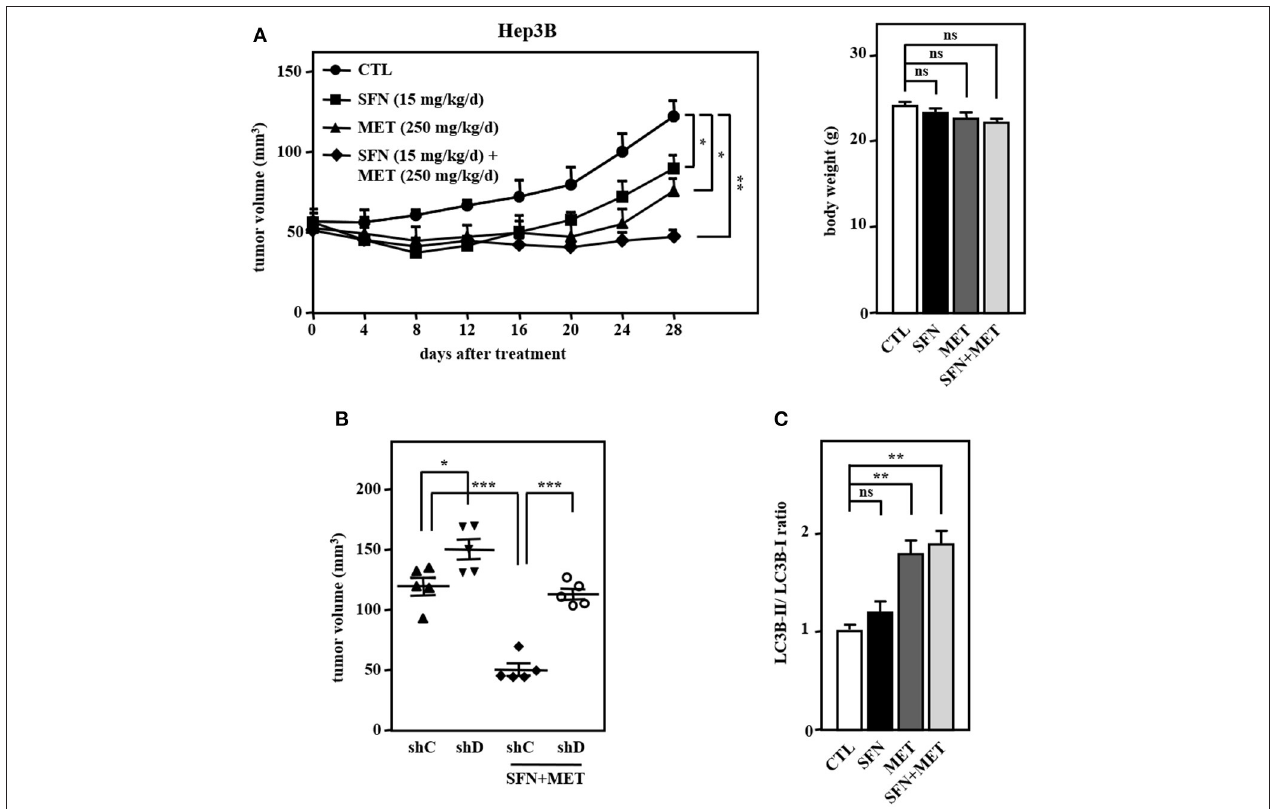
FIGURE 6 | The combination of sorafenib and metformin elicits stronger cytotoxicity in a Hep3B cell xenograft mouse model. Hep3B cells were subcutaneously inoculated into NOD-SCID mice, and the mice then received an intraperitoneal injection of vehicle, sorafenib (15 mg/kg/day), metformin (250 mg/kg/day), or sorafenib (15 mg/kg/day) combined with metformin (250 mg/kg/day). (A) Tumor dimensions were obtained at the indicated time points. Following 4 weeks of drug treatment, the mice were sacrificed, and animal weights were obtained. (B) Hep3B cells were infected with lentiviruses to drive the stable expression of either IPTG-inducible LacZ shRNA (shC) or IPTG-inducible CEBPD shRNA (shD). Infected Hep3B cells were subcutaneously inoculated into the dorsum of 6-week-old NOD-SCID mice ( n = 5), and the mice then received an intraperitoneal injection of 200 µ l IPTG (0.53 mmol) every other day. The mice were then treated with or without sorafenib (15 mg/kg/day) combined with metformin (250 mg/kg/day) via intraperitoneal injection. After 28 days of treatment, the mice were sacrificed, and the tumor volume was measured. (C) After 28-day treatment, the lysates extracted from these experimental xenograft tumors were collected and analyzed by Western blotting. The data are shown as the mean ± SD. * P < 0.05; ** P < 0.01; *** P < 0.001 by Student’s t